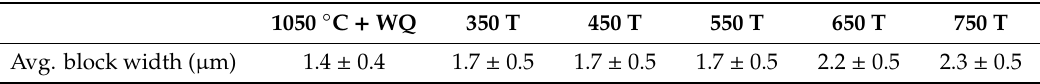
Table 1. E ff ect of tempering temperature on martensite block size (Here ‘WQ’ refers to Water Quench and ‘T’ refers to tempering